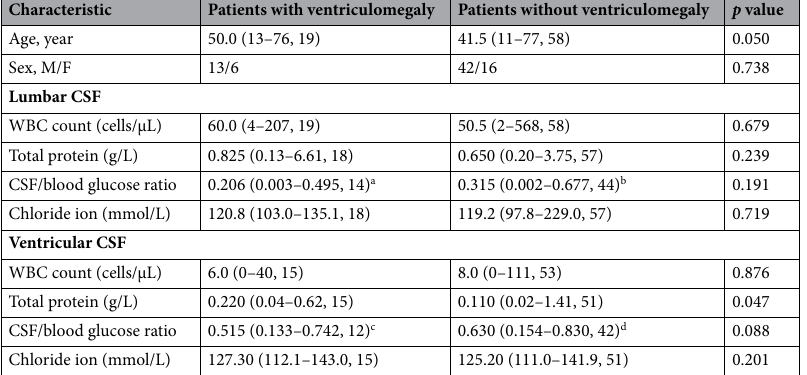
Table 3. Comparison of CSF parameters between patients with and without ventriculomegaly before ventriculoperitoneal shunt. Data presented as the median [Range, n] or n. M: male; F: female. n: data available for indicated parameters. a,b,c,d 4, 13, 3 and 9 patients lacked contemporaneous blood glucose values respectively.